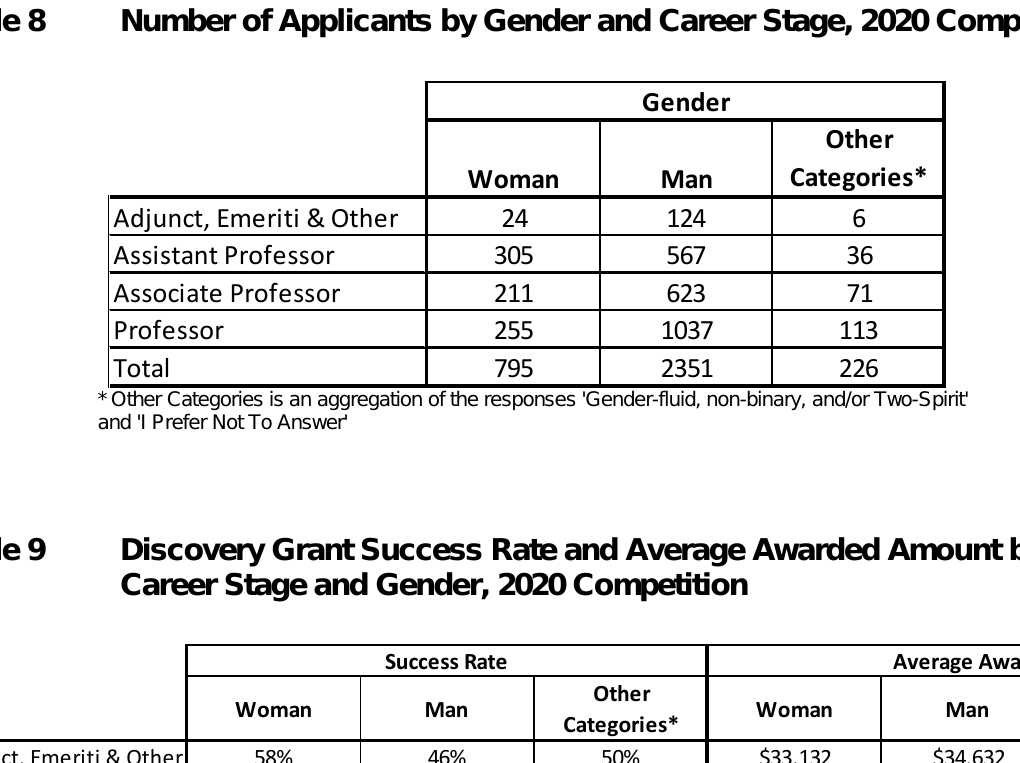
SECTION 3 – GENDER-DISAGGREGATED COMPETITION STATISTICS Number of Applicants by Gender and Career Stage, 2020 Competition